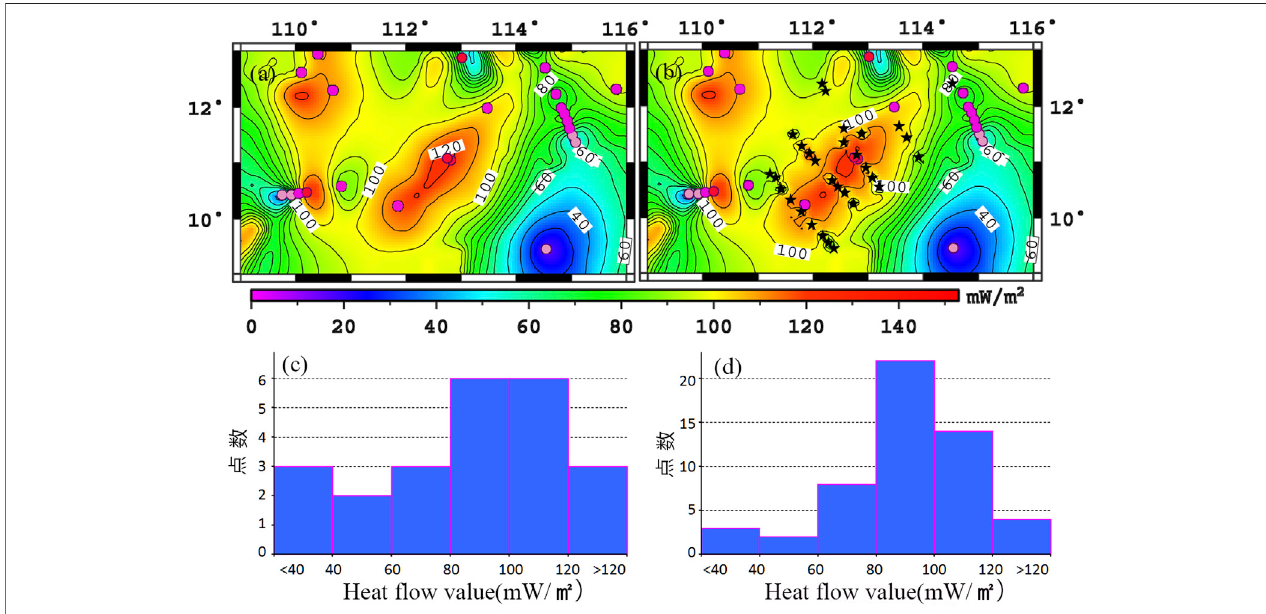
FIGURE8| Comparisonandanalysisofnewandoldsubmarineheat fl owdata. (A) Submarineheat fl owmapwithpreviousdata. (B) Submarineheat fl owmapwith the added new data. (C) Diagram of statistical distribution using the old data. (D) Diagram of statistical distribution using the added new data.